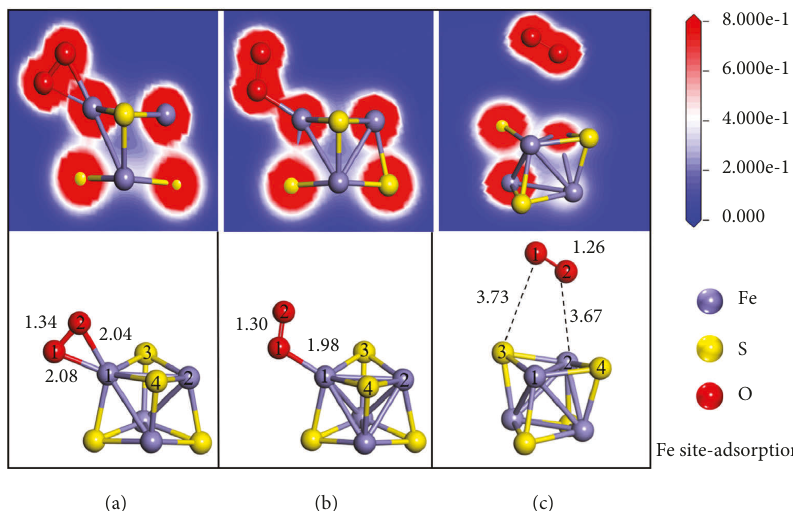
Figure 3: Adsorption structures of O 2 on Fe sites on Fe 4 S 4 clusters and the charge density of each adsorption structure. The bond lengths in the figure are in ˚A, 1 ˚A � 1 ∗ 10 − 10 m; the blue part of the charge density diagram indicates no charge aggregation, and the red part indicates charge aggregation.